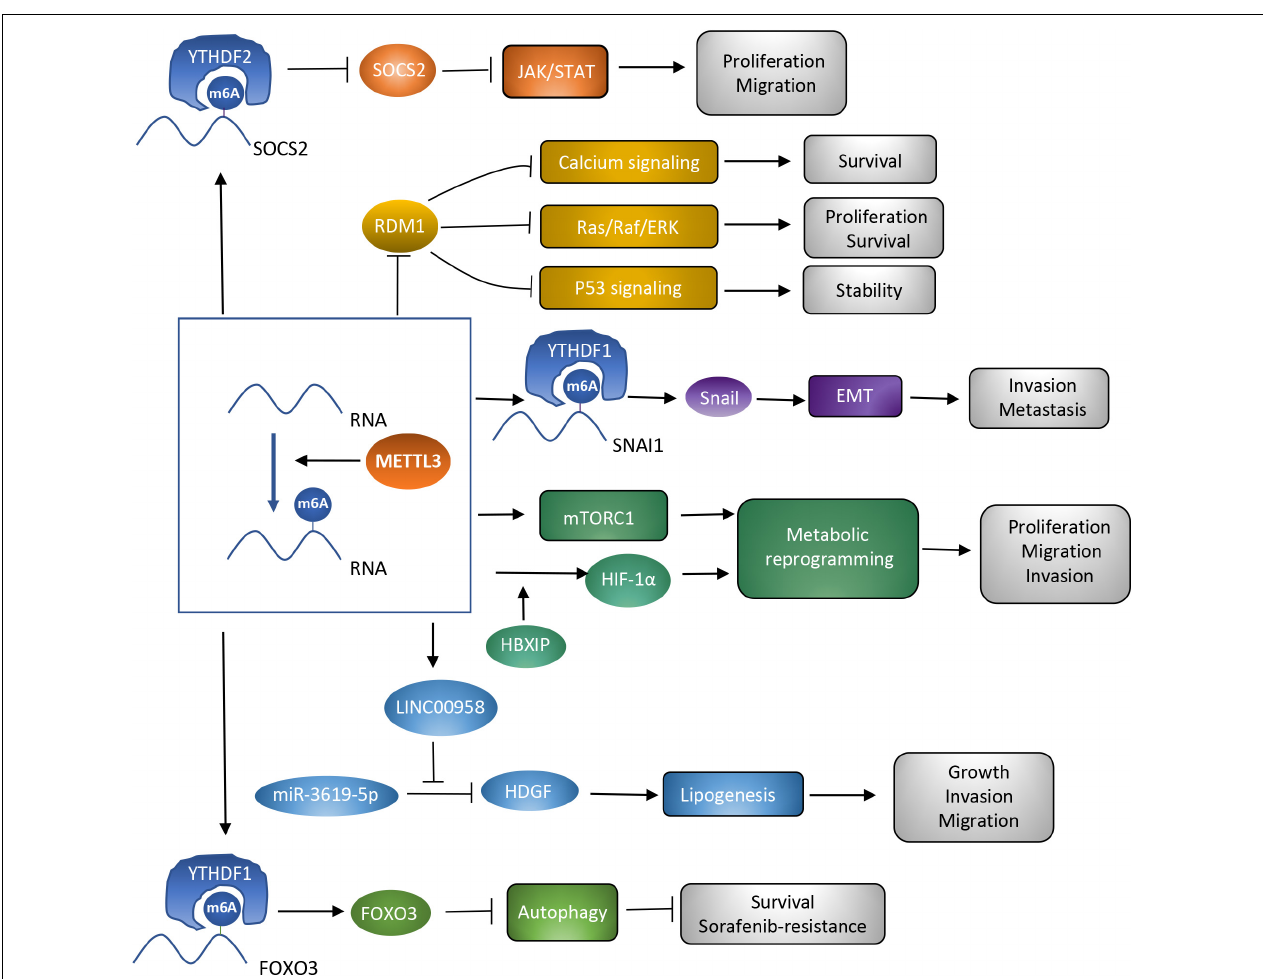
FIGURE 2 | Roles of METTL3 as a methyltransferase in HCC. Different targets of METTL3 are associated with diverse signaling pathways and biological processes, which contribute to the different influences of METTL3 on